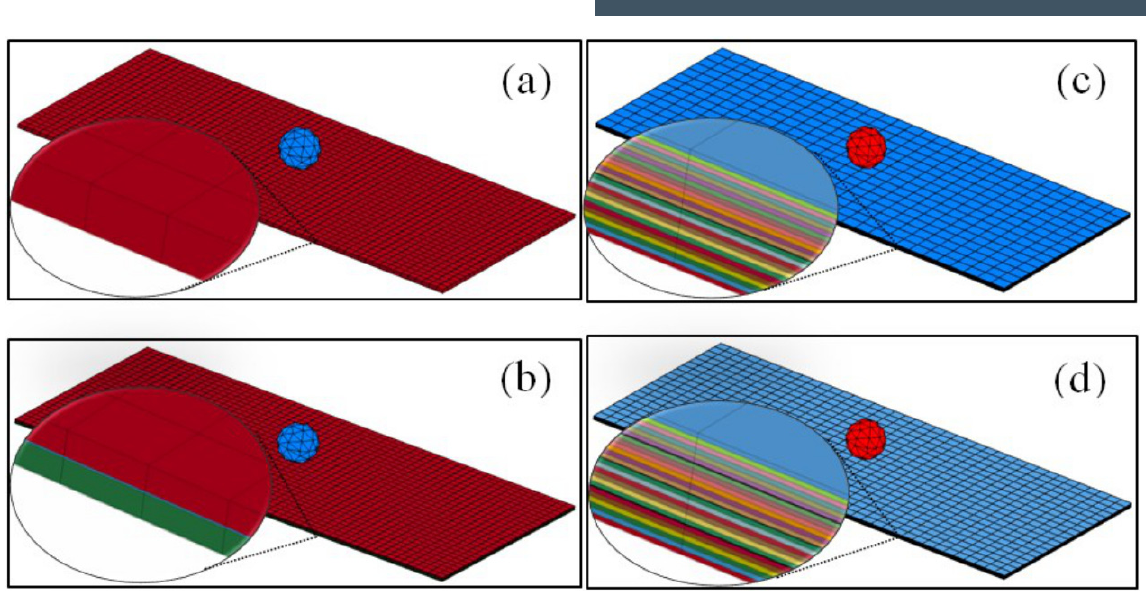
Figure 4. FE models of impacted laminated composite plate (a) one TSHELL; (b) two TSHELL sublaminates with a CZ layer; (c) SL-CZ-SL and (d) SL-CZ-SL-CZ-SL-CZ-SL (black lines between layers in (c) and (d) are the cohesive